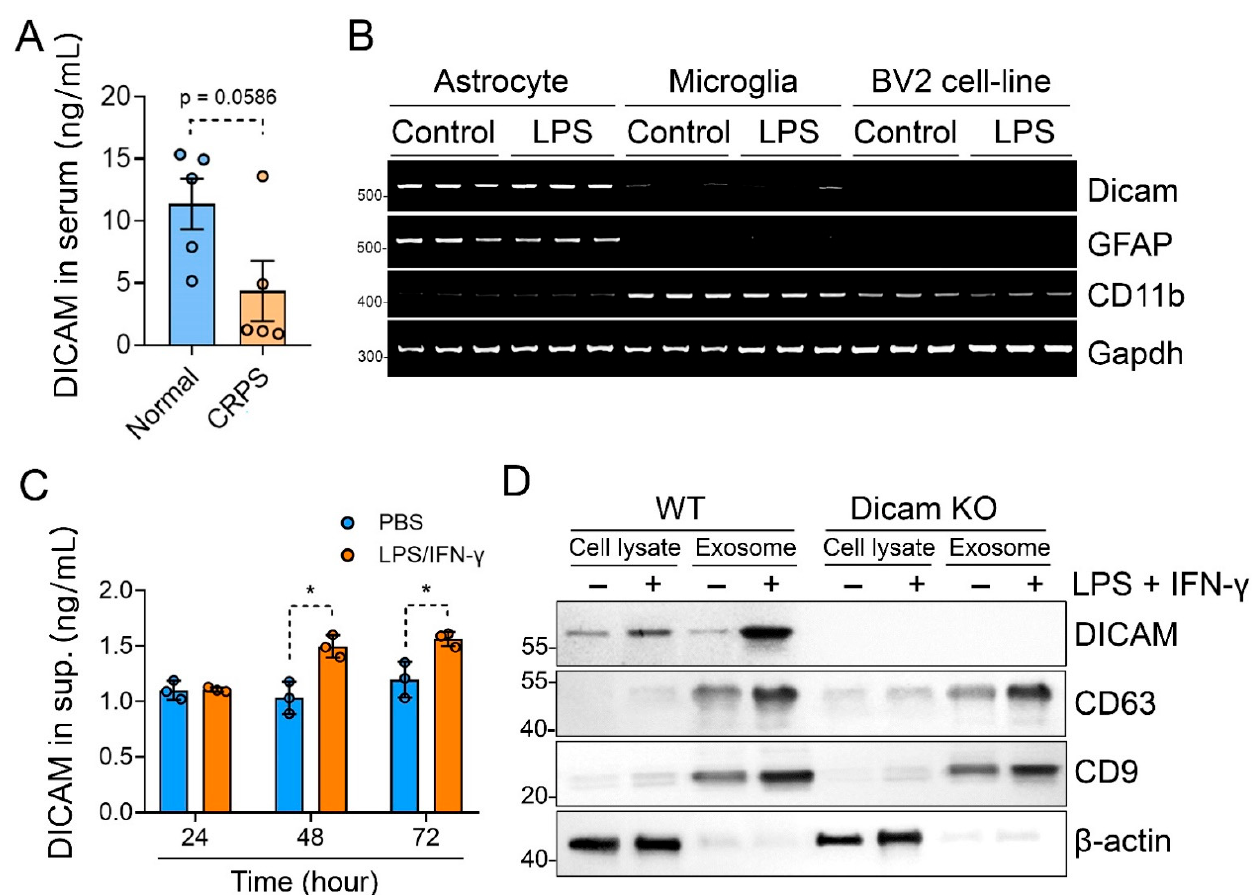
Figure 4. DICAM is highly enriched in the exosome from stimulated primary astrocytes. ( A ) Serum DICAM levels from patients with CRPS and age- and sex-matched healthy controls were determined using ELISA analysis and compared by Mann–Whitney U test. n = 5 per group. ( B ) RT-PCR analysis for DICAM, GFAP (a marker for astrocyte), and CD11b (a marker for microglia) were performed with mRNA isolated from primary astrocytes, primary microglia, and murine microglia cell-line BV-2. ( C ) The protein level of DICAM in the culture supernatants of WT primary astrocytes was measured using ELISA analysis. Primary astrocytes were treated with 100 ng/mL of LPS and 10 ng/mL of IFN- γ for 24 h. * p < 0.05 by Mann–Whitney U test. n = 3 per group. ( D ) Representative Western blot image of the total cell lysates and exosomes secreted by primary astrocytes in the medium showing DICAM and CD63 expressions (a marker for exosome).